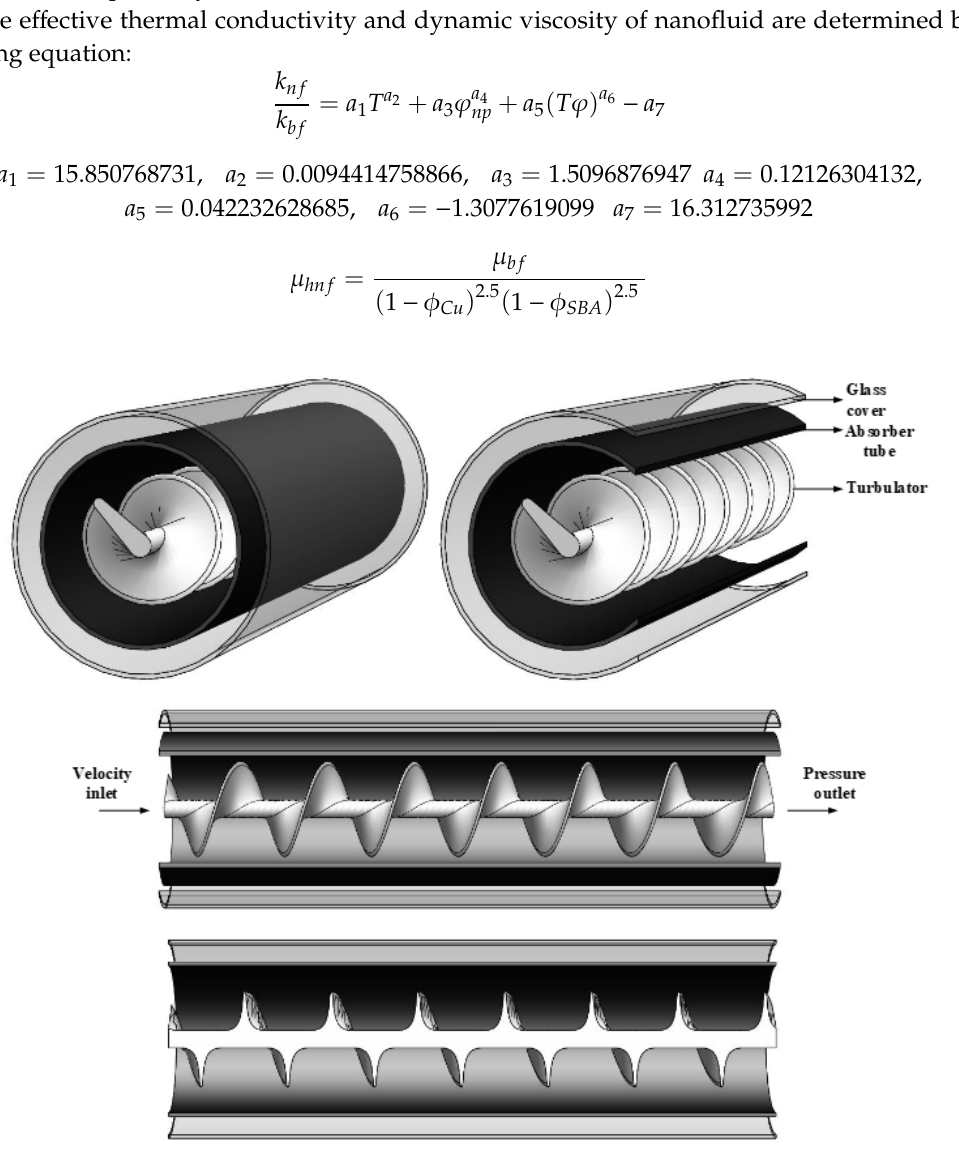
Figure 1. Schematic diagrams of the studied capsule heat exchanger and its geometrical parameters.